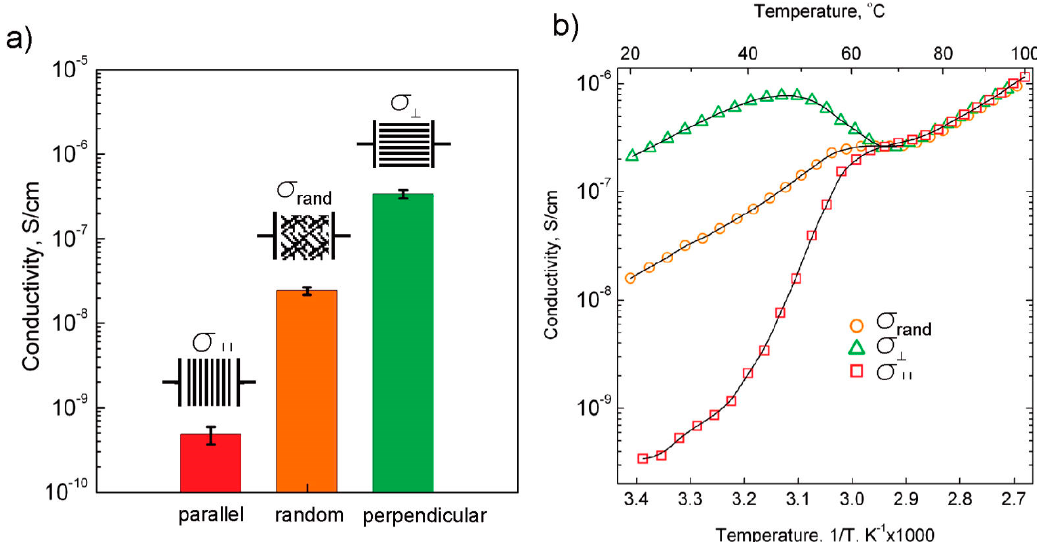
Figure 8. ( a ) Average room temperature conductivity of poly(ethylene oxide- b -6-(4 ′ -cyanobiphenyl- 4-yloxy)-hexyl methacrylate) PEO-b-PMA/CB (10.4 kg/mol, PDI = 1.15, f PEO = 0.23, EO:Li + = 120:1) aligned in 5 T magnetic field in two orthogonal directions; the nonaligned material conductivity is shown for comparison; ( b ) Temperature dependence of conductivities shown in an Arrhenius-type plot ( x -axis reversed). Reproduced with permission from Majewski et al. [103]. Copyright 2010, American Chemical Society.